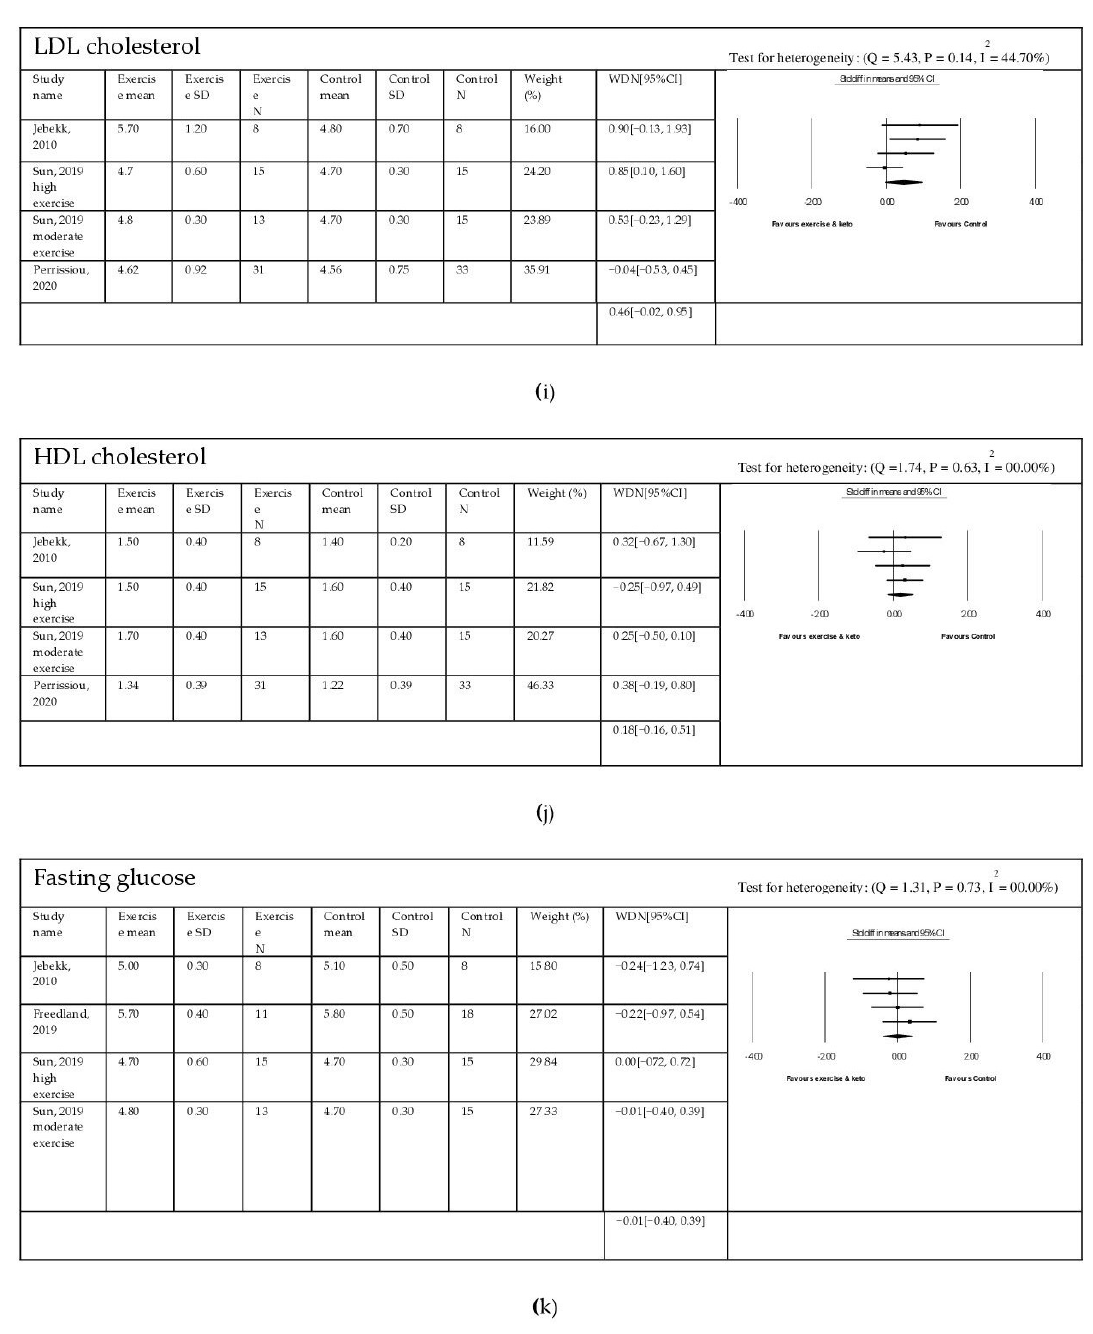
Figure 2. Effect sizes of exercise and ketogenic diet intervention for overweight and obese individual: ( a ) Effects of combined exercise and low carbohydrate ketogenic diet interventions on waist circumference, ( b ) Effects of combined exercise and low carbohydrate ketogenic diet interventions on weight, ( c ) Effects of combined exercise and low carbohydrate ketogenic diet interventions on body mass index, ( d ) Effects of combined exercise and low carbohydrate ketogenic diet interventions on lean body mass, ( e ) Effects of combined exercise and low carbohydrate ketogenic diet interventions on body fat mass, ( f ) Effects of combined exercise and low carbohydrate ketogenic diet interventions on Cardiorespiratory fitness (VO 2peak ), ( g ) Effects of combined exercise and low carbohydrate ketogenic diet interventions on Triglycerides, ( h ) Effects of combined exercise and low carbohydrate ketogenic diet interventions on total cholesterol, ( i ) Effects of combined exercise and low carbohydrate ketogenic diet interventions on LDL cholesterol, ( j ) Effects of combined exercise and low carbohydrate ketogenic diet interventions on HDL cholesterol, ( k ) Effects of combined exercise and low carbohydrate ketogenic diet interventions on fasting